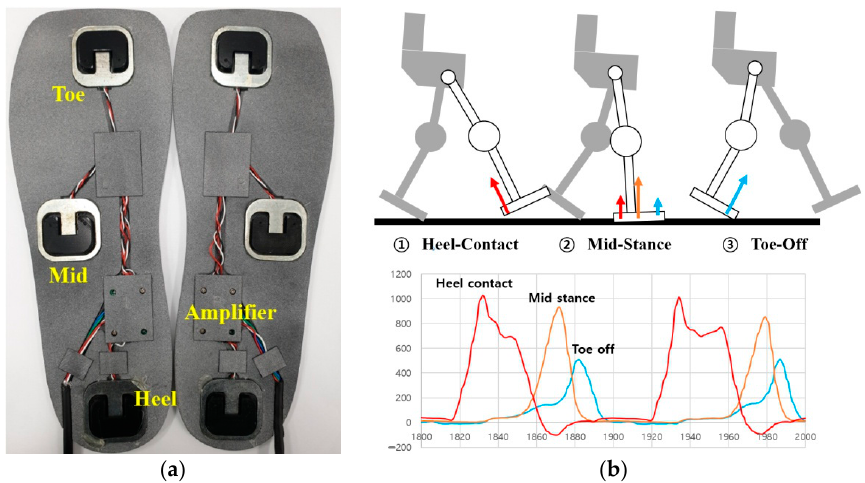
Figure 5. The developed GRF sensor module. ( a ) The sensor configuration with three load cells; and ( b ) an example of sensor signal outputs and gait mode identification.